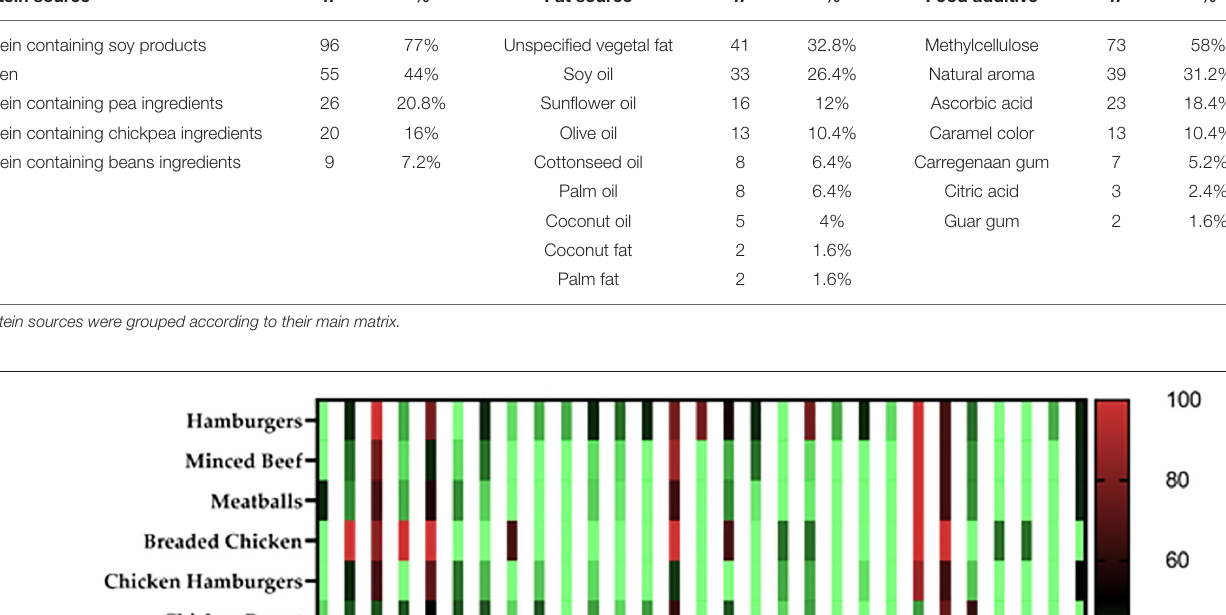
TABLE 2 | Main protein and fat sources and food additives according to their frequency of mentioning in all samples’ food labels of vegan meat alternatives. Protein source* n % Fat source Protein containing soy products